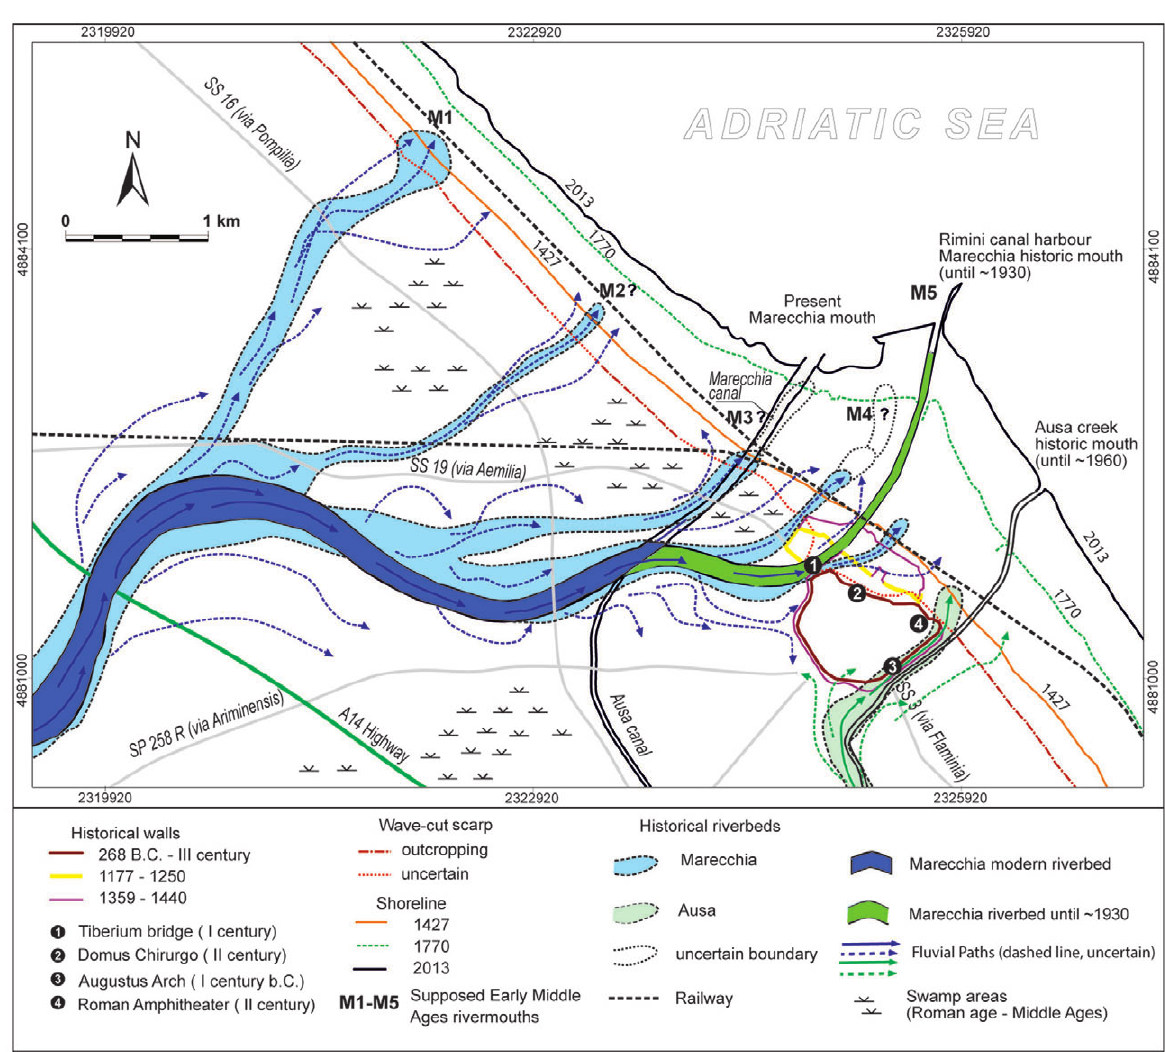
Fig. 2. Morpho-evolutive reconstruction of the Rimini ( Ariminum )